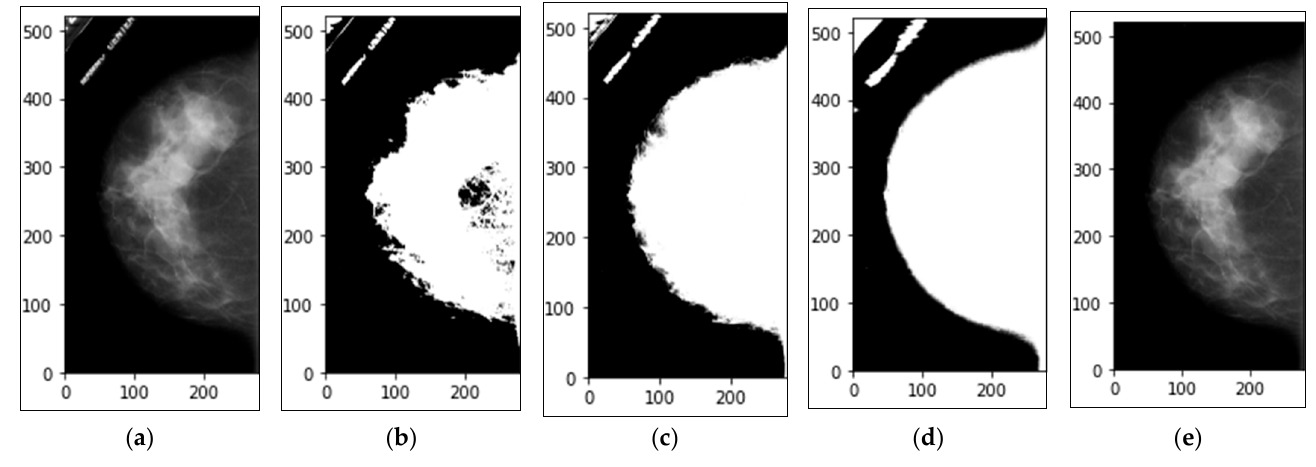
Figure 3. Data preprocessing to extract the whole breast region of interest (ROI) as well as remove the unwanted information using the custom built in image processing technique. ( a ) The original mammogram, ( b ) the generated image binary mask using THRESH_OTSU operator, ( c ) the gener- ated image binary mask using THRESH_BINARY operator, ( d ) the generated image binary mask using THRESH_TRIANGLE operator, and ( e ) the corresponding breast image after applying the processing technique.